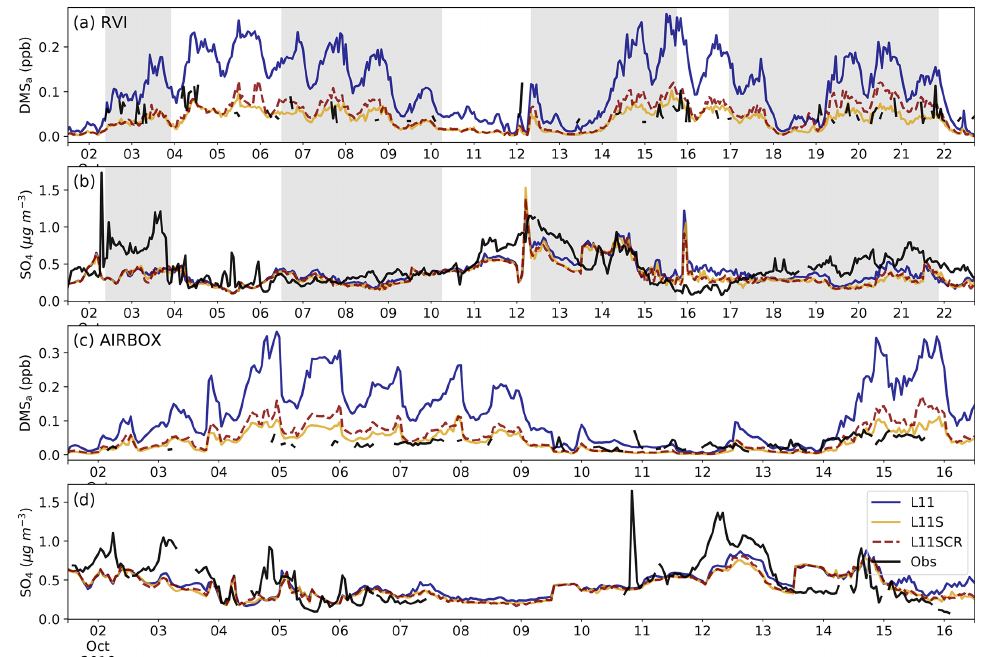
Figure 3. Observations (black) from the RVI (a, b) and AIRBOX (c, d) and corresponding model estimates (coloured) of (a, c) DMS a (ppb) and (b, d) SO 2 − aerosol mass (µgcm − 3 ). The three WRF-Chem simulations are L11 (blue), L11S (yellow) and L11SCR (dashed red). The 4 grey shading from left to right indicates when the ship was at station locations 2, 3.1, 3.2 and 4. Note that the dates in (a) , (b) and (c) , (d) are not the